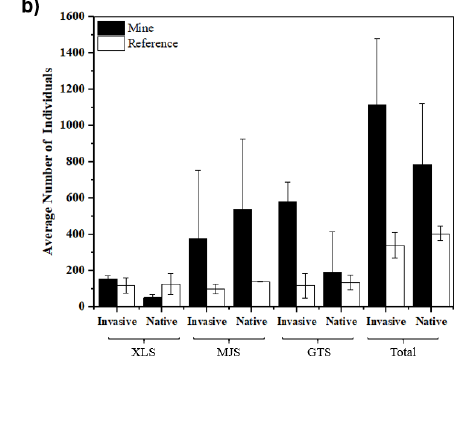
Figure 4. Histogram showing the distribution of plant species across varying levels of abundance at each location: ( a ) XLS, ( b ) MJS, ( c ) LWS, and ( d ) GTS. The sampling at LWS was conducted only during spring 2022 when the GTS site pair was inaccessible.